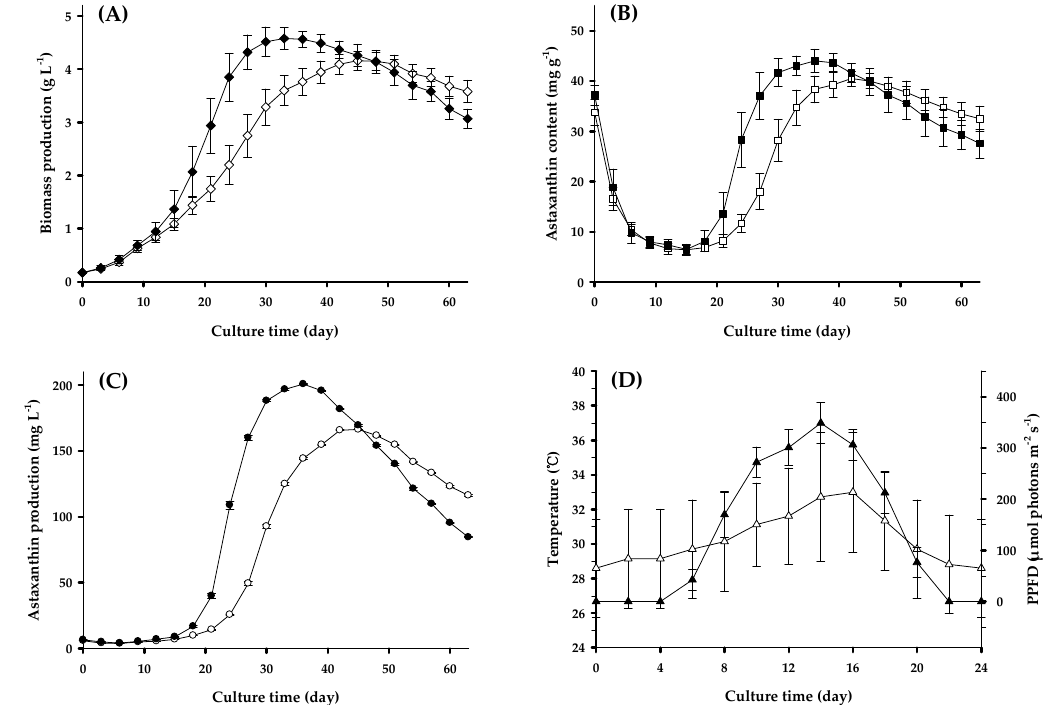
Figure 4. Comparison of ( A ) biomass production (diamond), ( B ) astaxanthin content (square), and ( C ) astaxanthin concentration (circle) from H. pluvialis cells of wild type (white) and the mutant PP-PS 160 (black) under high-temperature conditions in summer. ( D ) Photosynthetic photon flux density (PPFD) (black triangle) and medium temperature (white triangle) during the daylight period in spring (June–August). Each value is mean ± standard deviation of three replicates.